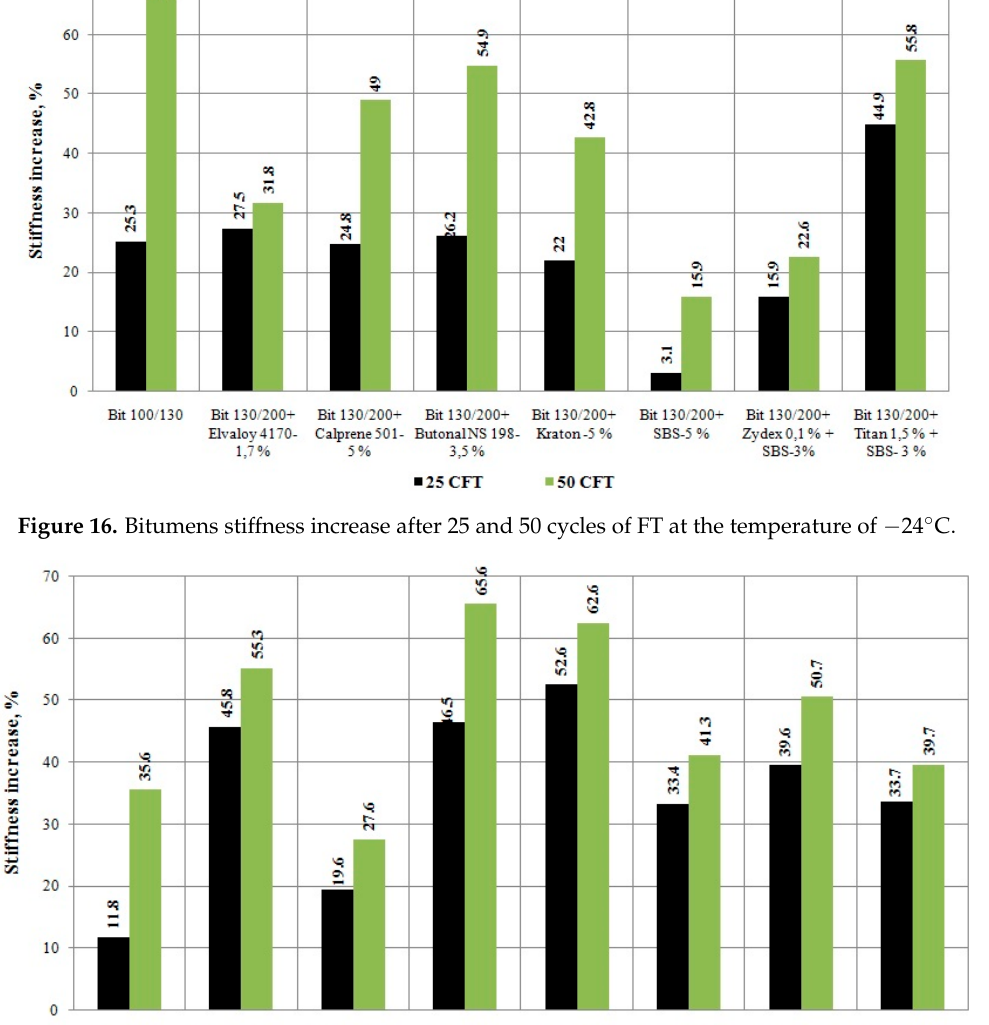
Figure 15. Bitumens stiffness at the temperature of –36° С .